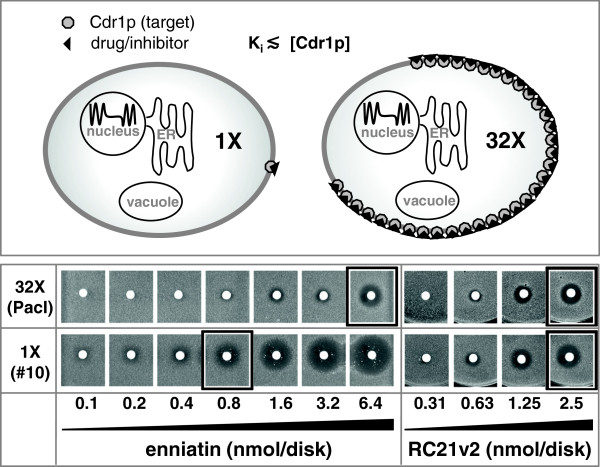
Demonstration of Cdr1p target concentration-dependent chemosensitization to enniatin and RC21v2. The top panel illustrates the theoretical assumption that 32 times more of a high-affinity Cdr1p inhibitor (Ki ≪ [Cdr1p]) is required to inhibit a strain that expresses 32 times more Cdr1p. Yeast strains AD∆/P-CDR1-URA3 (32X, top row) and AD∆/construct10-CDR1 (1X, bottom row) were used to test this theory. CSM agar plates contained [FLC] = ¼ MICFLC of these two test strains (Table 4). Filter disks containing 0.1 - 6.3 nmol of enniatin or 0.3 - 2.5 nmol of RC21v2 (applied at two-fold increasing amounts) were placed onto these plates after they had been seeded with yeast cells and incubated for two days at 30°C. The size of the growth inhibitory zones was used as a visual indicator for the level of Cdr1p inhibition. While ~10 times more enniatin was needed to inhibit wt-Cdr1p expressing cells (boxed disks) almost identical amounts of the Cdr1p inhibitor RC21v2 were required to inhibit the two test strains (boxed disks).